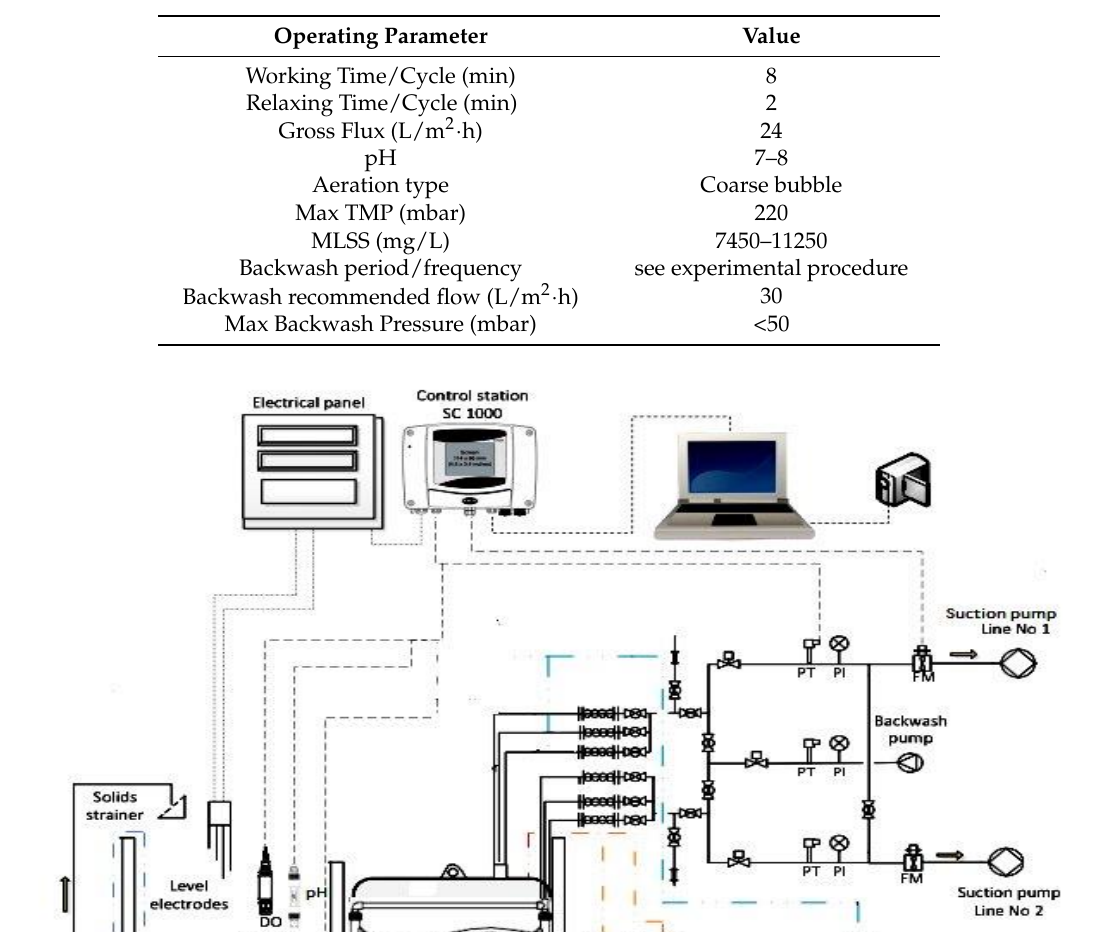
Table 2. Experimental conditions.